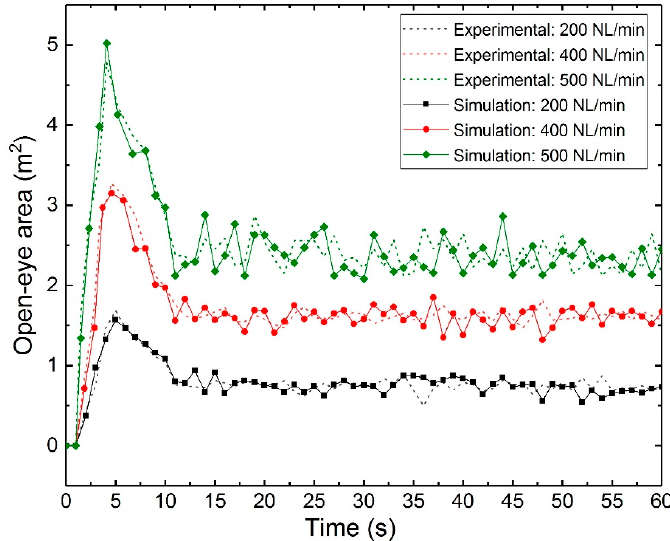
Figure 6. The dynamic open-eye area with time for experiments and simulation results.